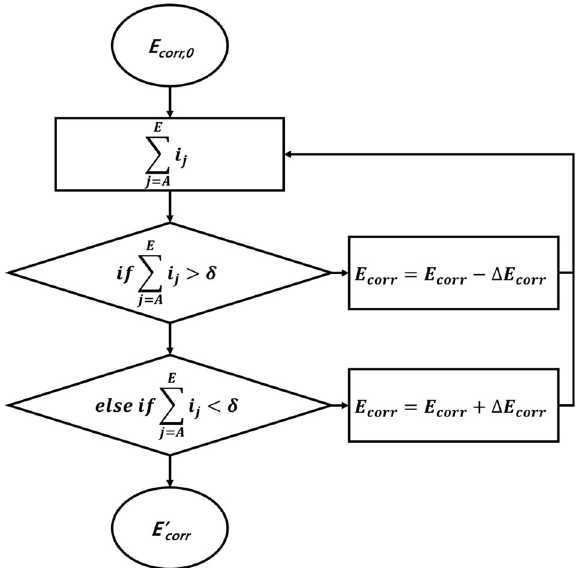
Fig. 19 Logic for calculating corrosion potential in the developed model. Schematic showing fl ow of numerical iterations for fi nding corrosion potential at speci fi c condition and time